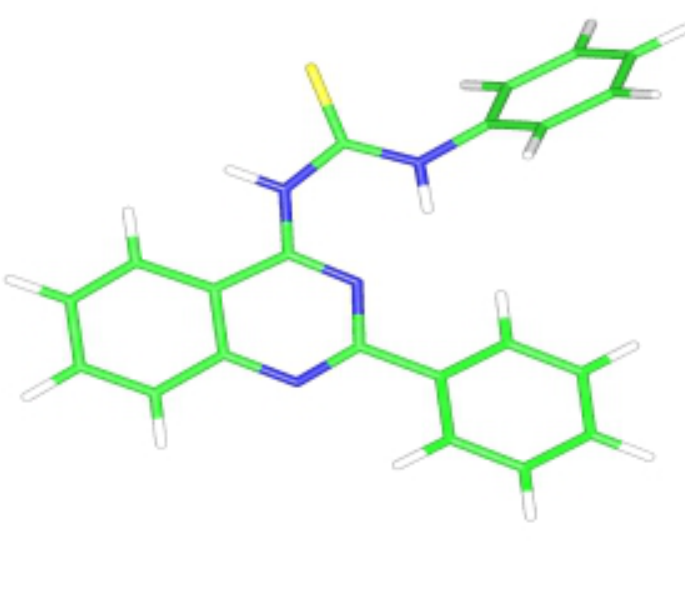
Figure 3: The calculated model of compound